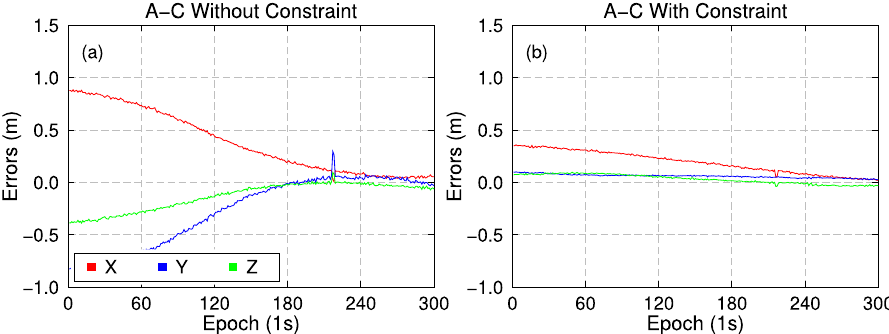
Figure 15. Widelane ambiguity float solutions of baseline A–B without ( a ) and with ( b ) static levelling constraint.